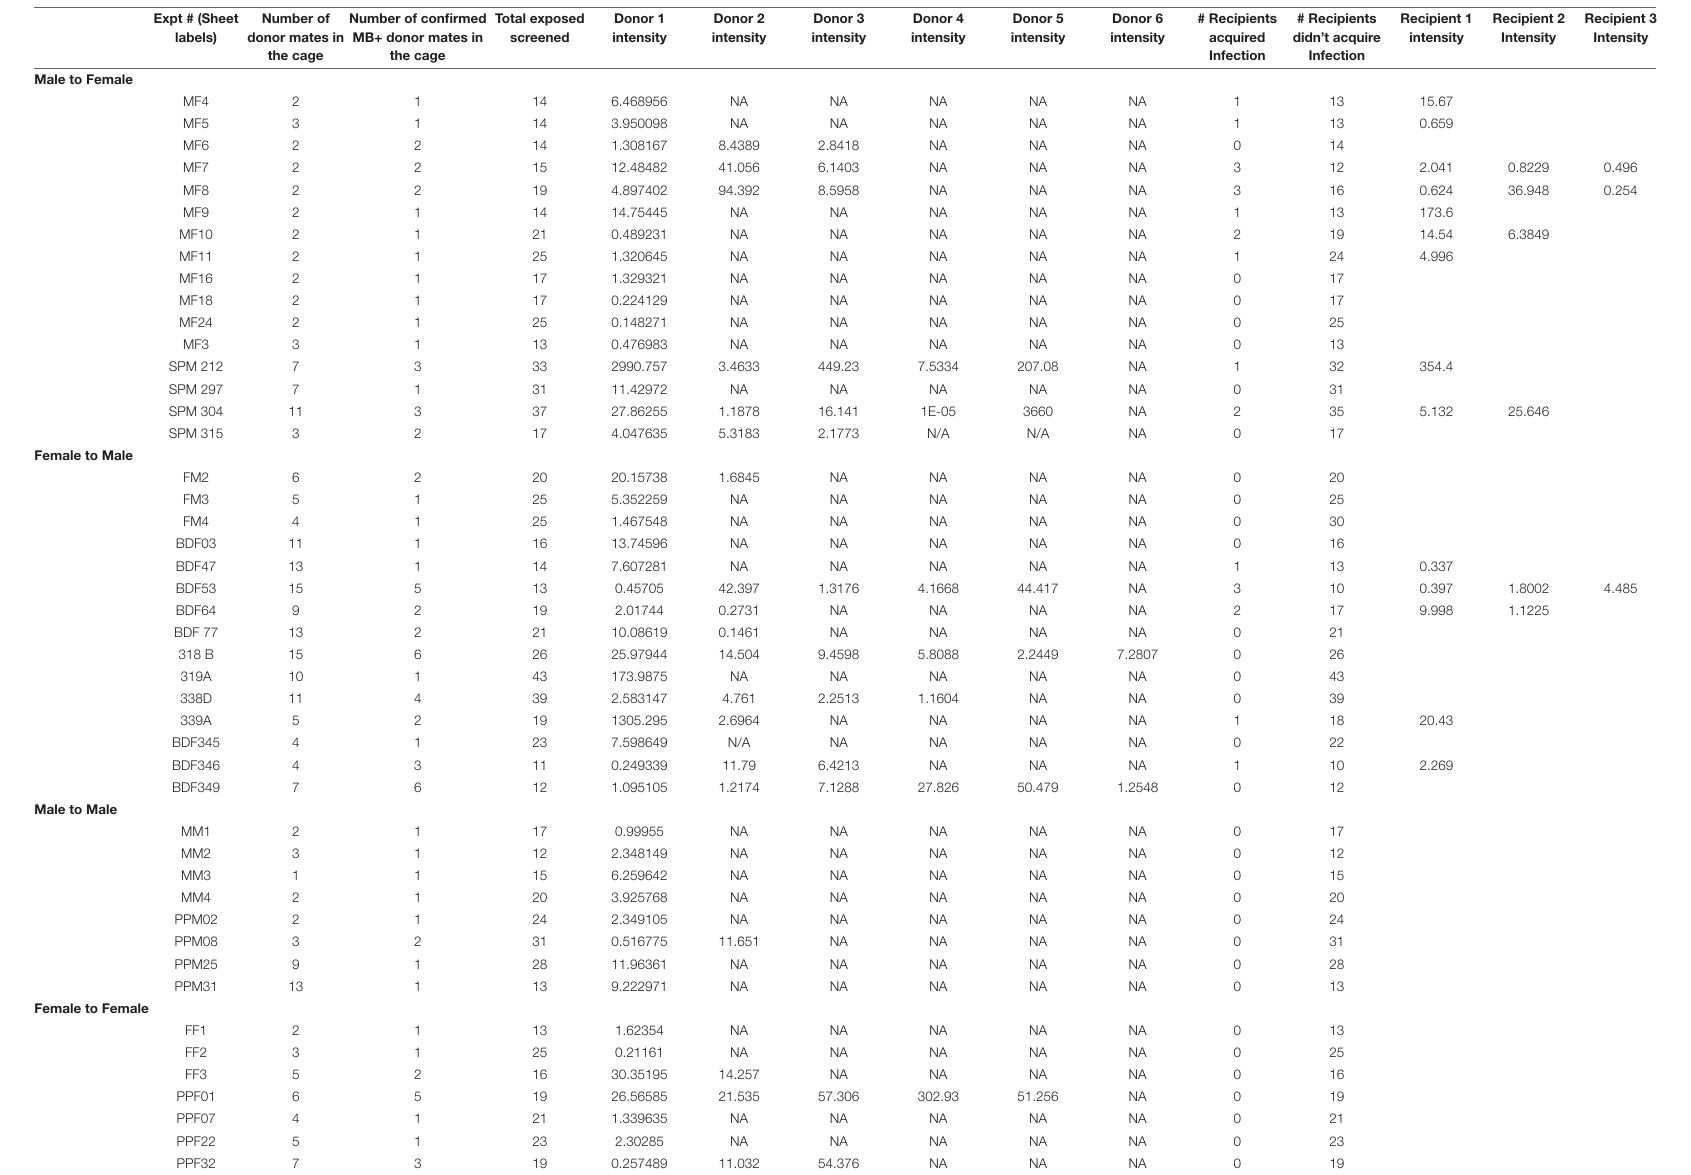
TABLE 4 | Horizontal transmission of Microsporidia MB between adults housed together in